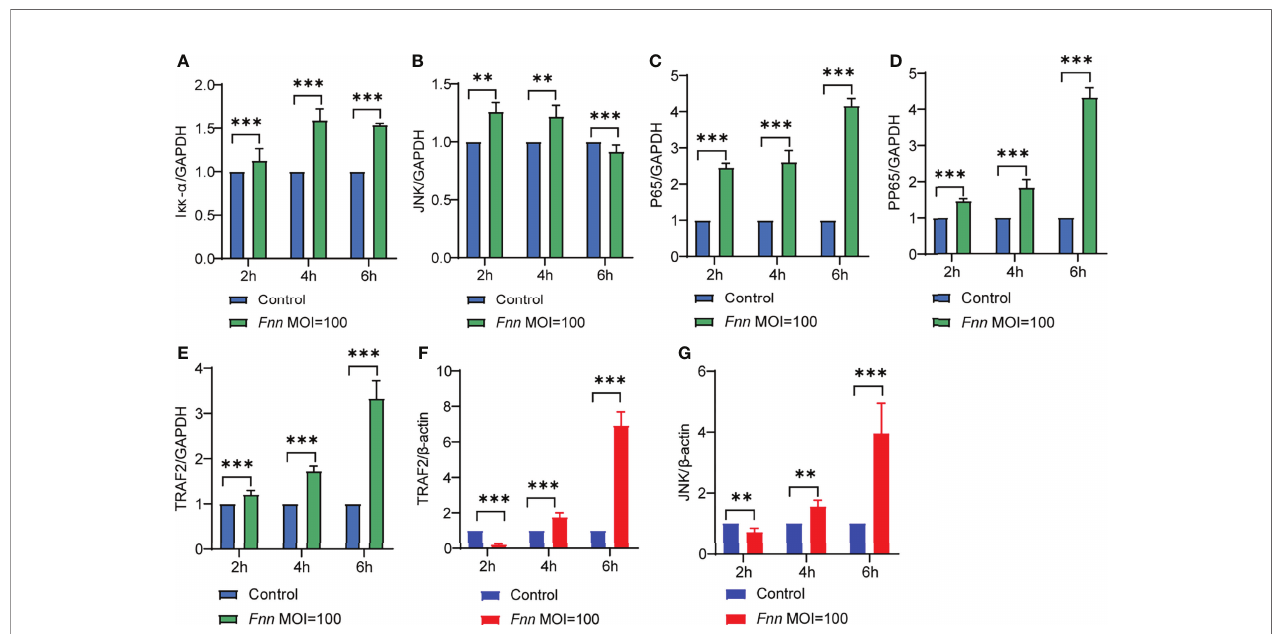
FIGURE 8 | Effects of F. necrophorum the activation of the NF- k B and mitochondrial signaling pathways in cells. I kka (A) , JNK (B) , NF- k B p65 (p65) (C) , phosphorylated NF- k B p65(pp65) (D) and TRAF2 (E) gene expression with F. necrophorum stimulation macrophages (MOIs of 0 and 100) from 0 to 6 h ( n = 3). TRAF2 (F) and JNK (G) gene expression with F. necrophorum stimulation sheep neutrophils cells (MOIs of 0 and 100) from 0 to 6 h ( n = 3). ** P <0.01, *** P